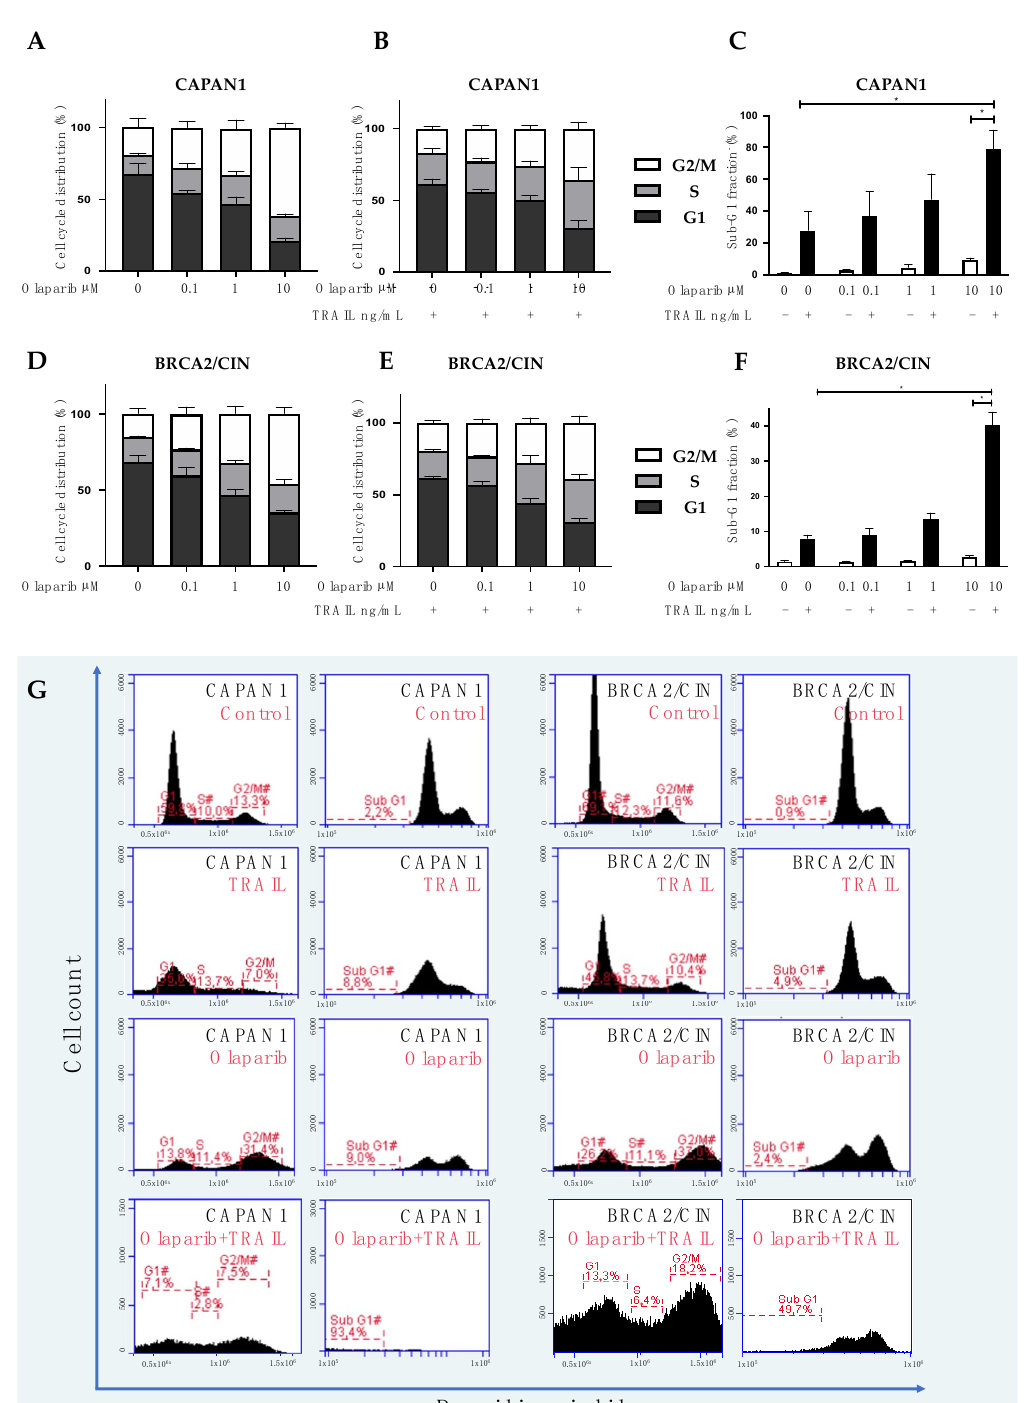
Figure 4. Combined olaparib and TRAIL enhance S/G2 phase cell cycle arrest and apoptosis. CAPAN1 ( A – C ), and the wild-type BRCA2 expressing BRCA2/CIN treated with various doses of olaparib alone ( A , D ) or in combination with TRAIL (10 ng/mL) ( B , C , E , F ) for 48 h. Figure 4A,B,D,E depict the percentage of cells in the respective cell cycle phase from all viable cells, i.e., non-sub-G1 cells. Figure 4C,F depict the percentage of cells in sub-G1 from all cells. Figure ( G ): Representative flow cytometry histograms of CAPAN1 and BRCA2/CIN cells after incubation with control, olaparib (10 μ M), TRAIL (10 mg/mL), or its combination. Error bars represent mean ± SEM from at least three experiments. * = statistical significance, p < 0.05.